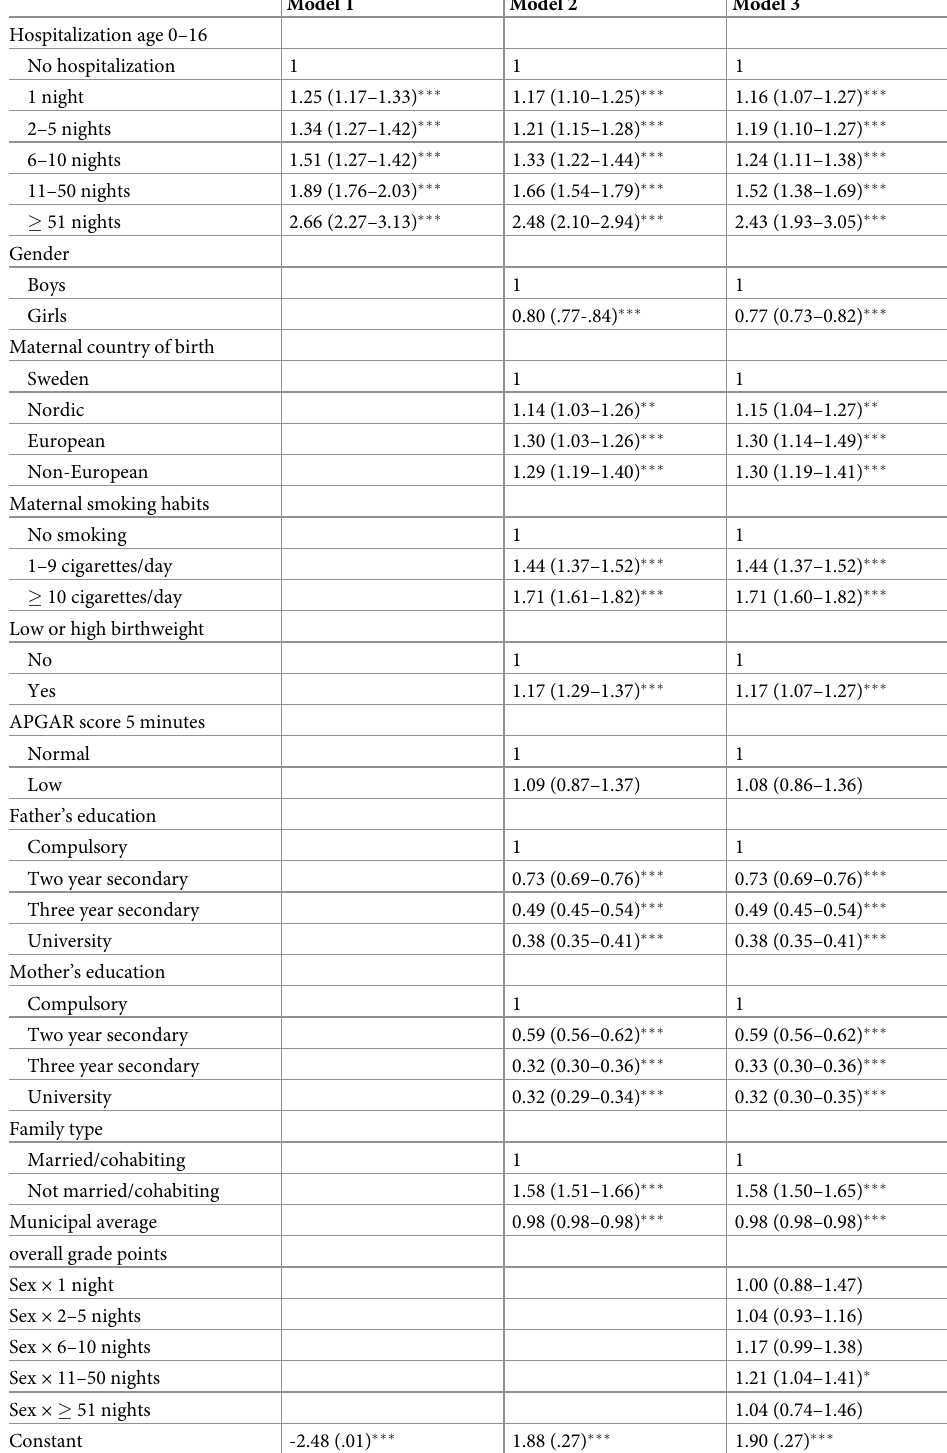
Table 4. Hospitalizations and odds ratios (OR) of ineligibility for upper secondary education . Confidence intervals (CI) in